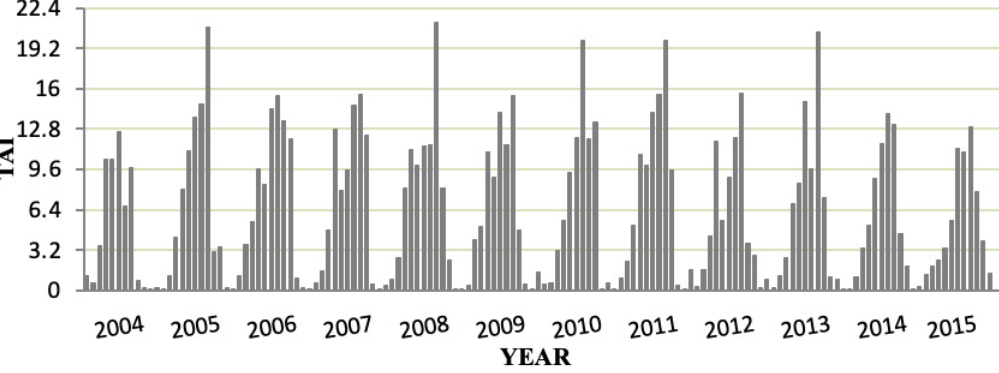
Figure 4. Thornthwaite aridity index (TAI); average monthly values for all 3 provinces.